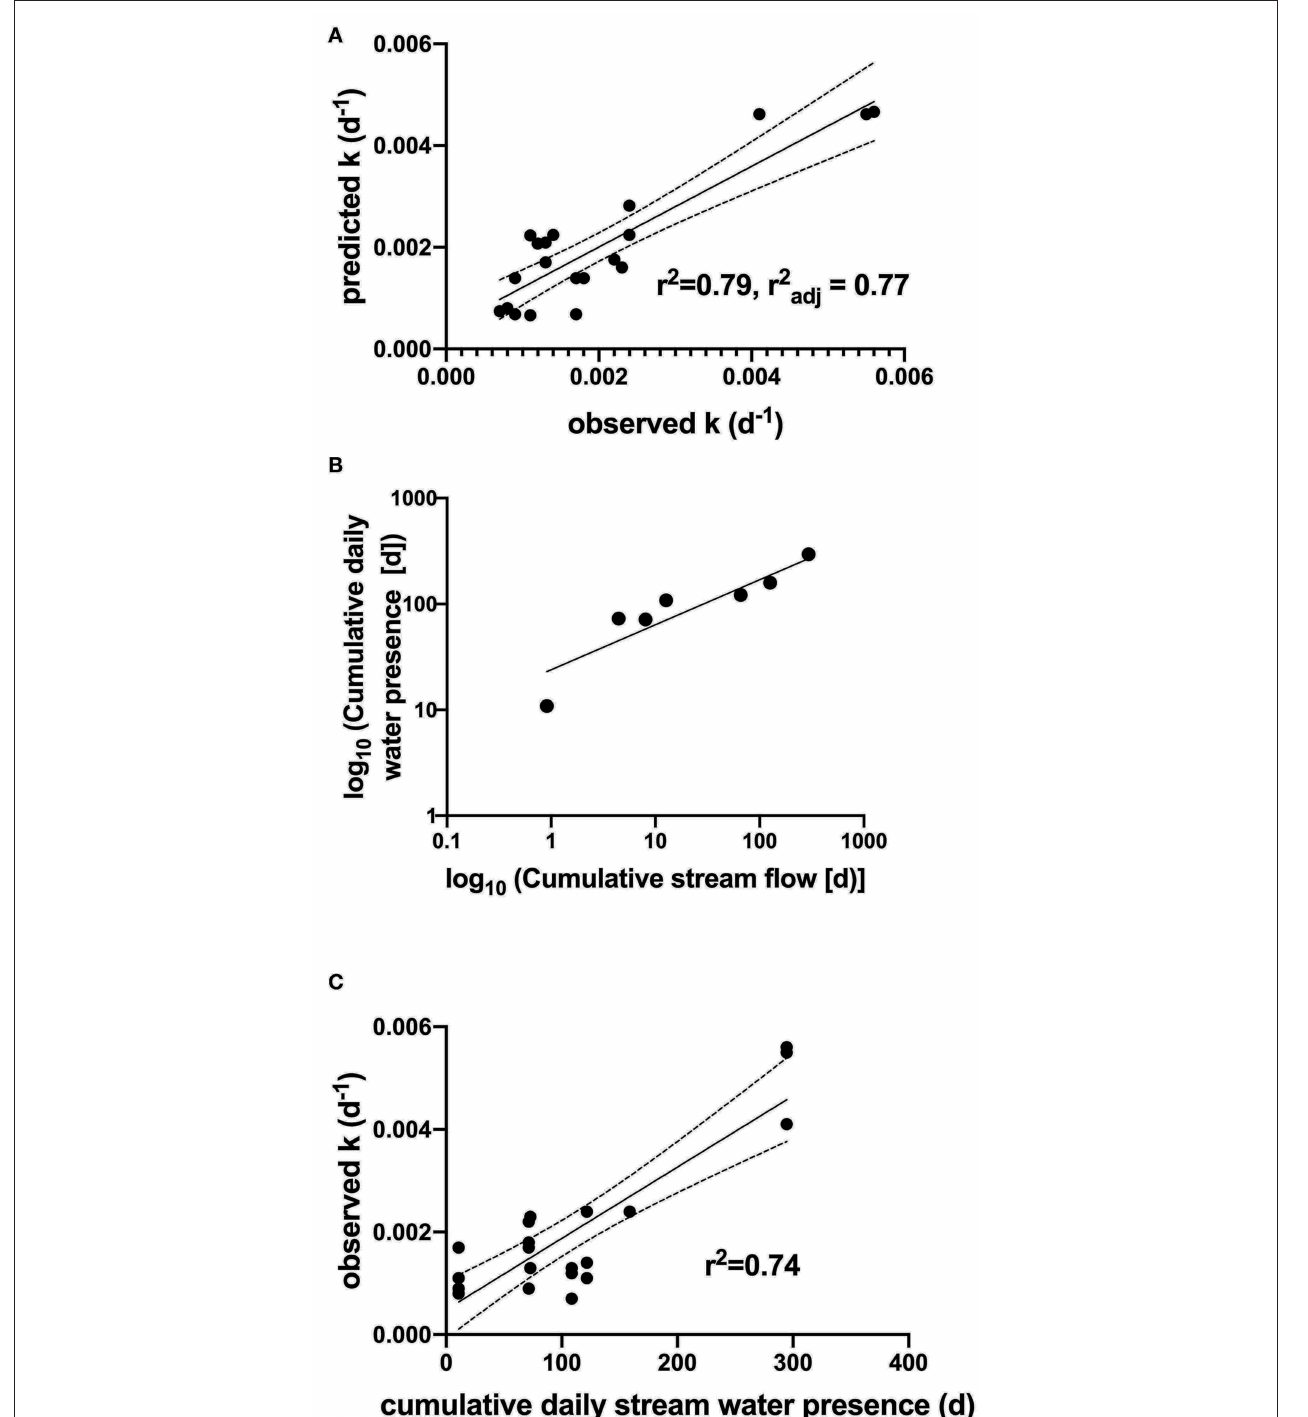
FIGURE 5 | (A) Cumulative daily stream water presence and % silt explain 79% of variation in decomposition rates (d − 1 ) in channels across flow regimes, (B) Log transformed cumulative daily stream presence is highly correlated to log transformed cumulative stream water flow days but detects water availability at lower flow conditions, (C) cumulative daily stream presence explain 74% of total variation in decomposition rates ( k ).